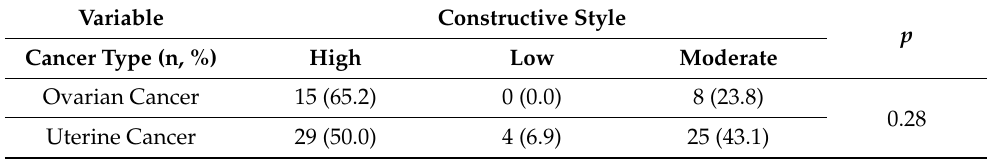
Table 4. Constructive and destructive style categories depending on the type of